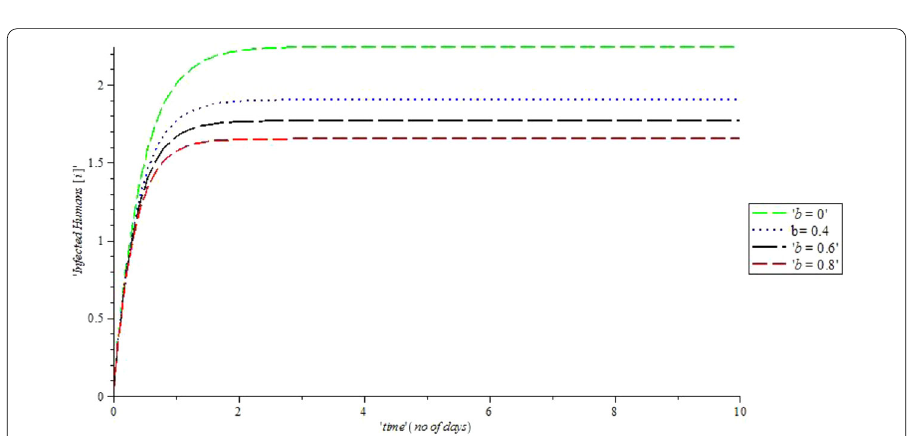
Figure 2 Effect of treatment on infected